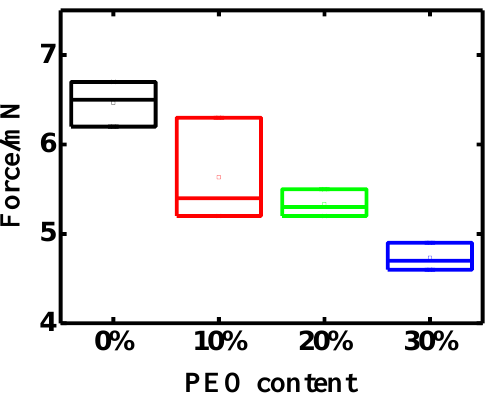
Figure 7. The peak − to − peak blocking force of PEO/Nafion − IPMC with varying PEO contents. Figure 7. The peak-to-peak blocking force of PEO/Nafion-IPMC with varying PEO The displacement and blocking force of IPMCs varied dramatically according to the